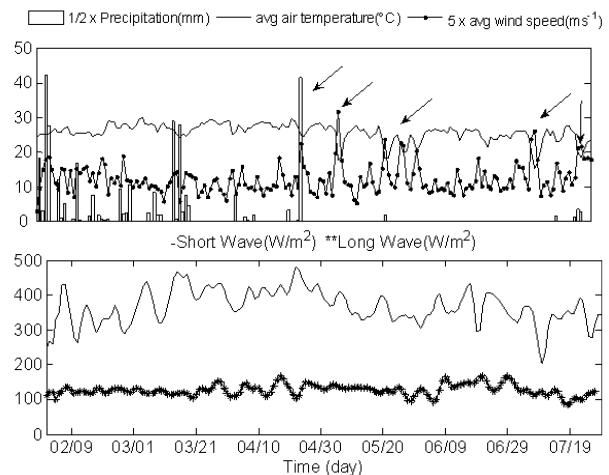
Figure 2: Daily means of air temperature, wind speed and precipitation (upper panel) and the daily means of solar short-wave radiation and long-wave fluxes (lower panel) from February to July 2007.